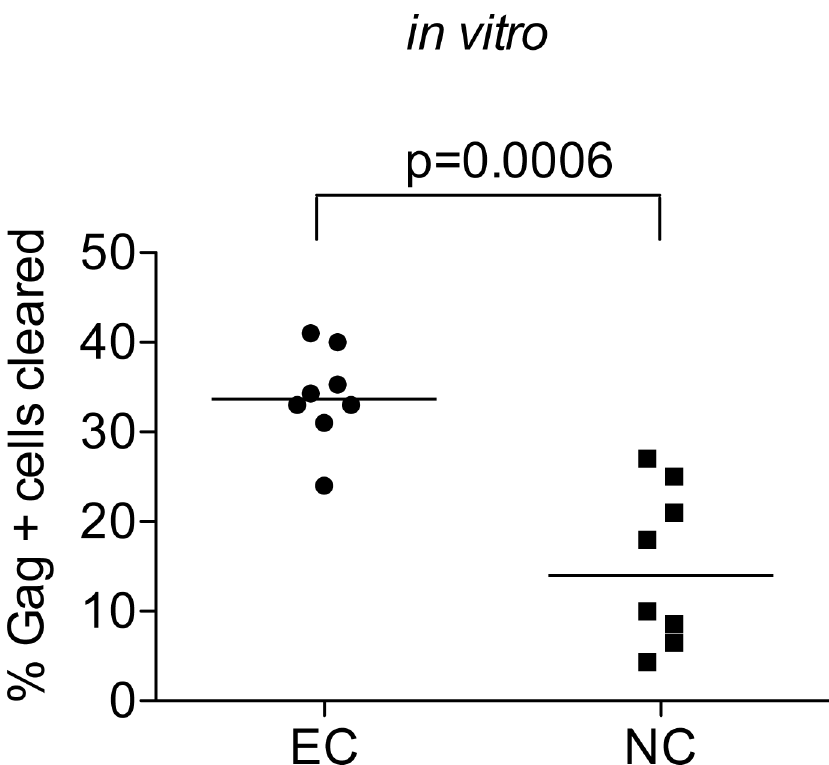
Figure 4. GPR cells are more efficiently cleared by CTL in EC than in non-controllers. The percent of GPR cells eliminated after 1 hour coculture with autologous CD8+T cells was compared between EC (n=8) and chronic non-controllers (n=8). The line represents the median and the p value was calculated by a Mann-Whitney